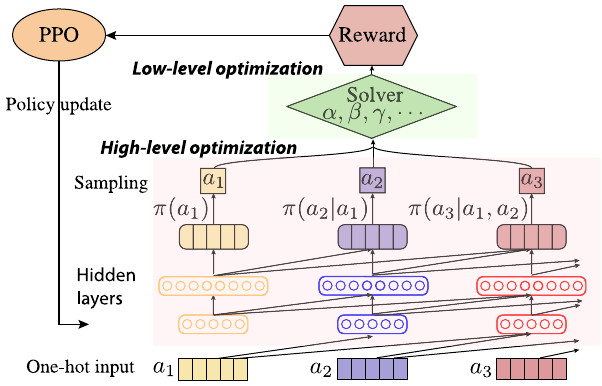
FIG. 9. Schematics of CD-QAOAwith an autoregressive policy network. The ancestral sampling procedure used for training is displayed in Fig. 10. The details of the network structure and its training hyperparameters are shown in Table